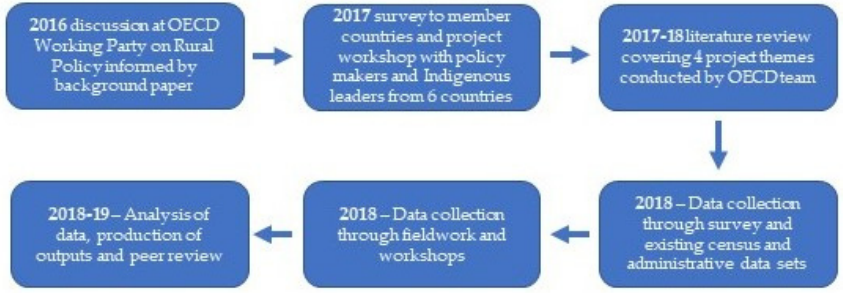
Figure 1. Summary of the research process.